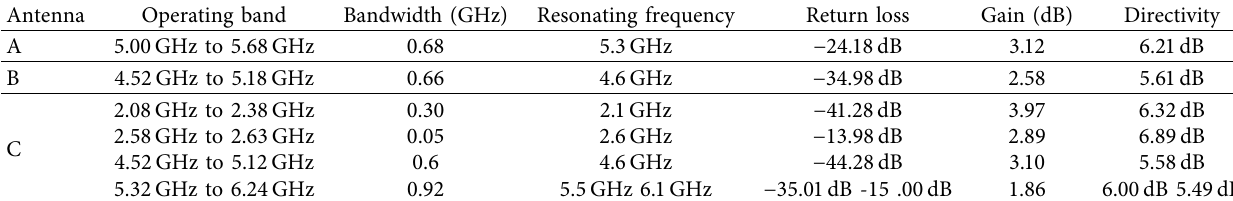
Table 3: Simulated result